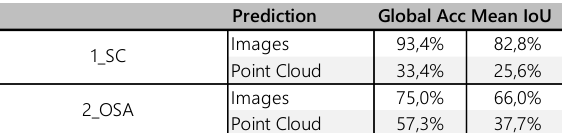
Figure 8: Back-Projection results for 1_SC: A) ground-truth cloud, B) image ground-truth reconstruction, C) prediction reconstruction.